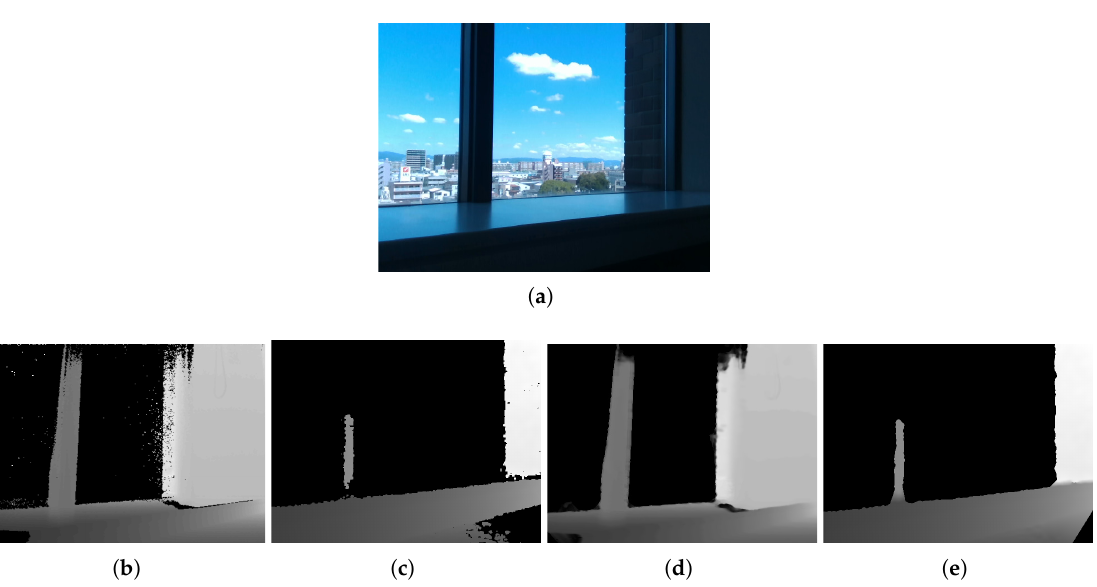
Figure 10. Inpainting results obtained with different sensors: ( a ) capture scene; ( b ) raw depth image from Kinect v2 (TOF); ( c ) raw depth image of RealSense SR300 (SL); and ( d , e ) inpainting results of ( b , c ).